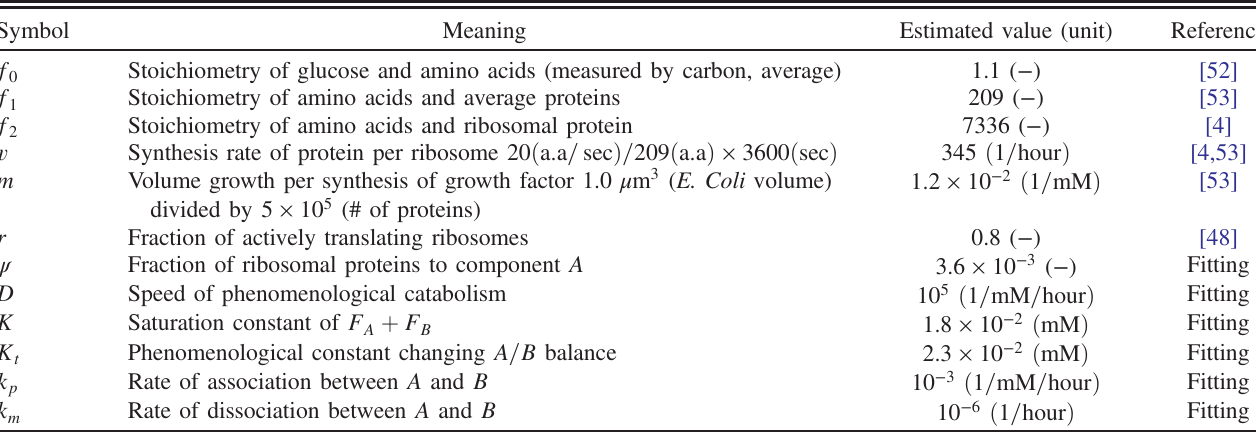
II. Estimated parameter values.